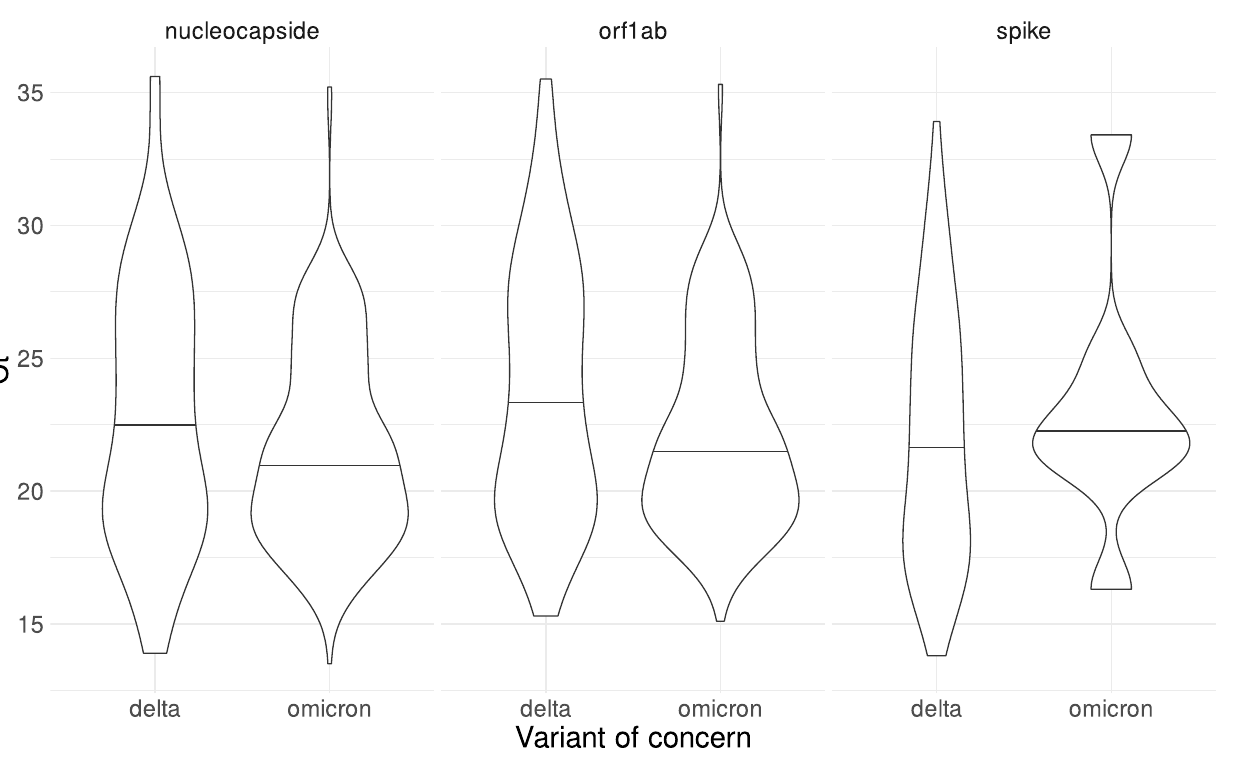
Figure 8. Ct distributions for each gene (nucleocapside, orf1ab, and Spike) used during the RT-qPCR test for Delta and Omicron SARS-CoV-2 samples. A two-sample t -test was performed for each marker. The corresponding p -value is shown in each case. The dashed lines represent the mean for each distribution.